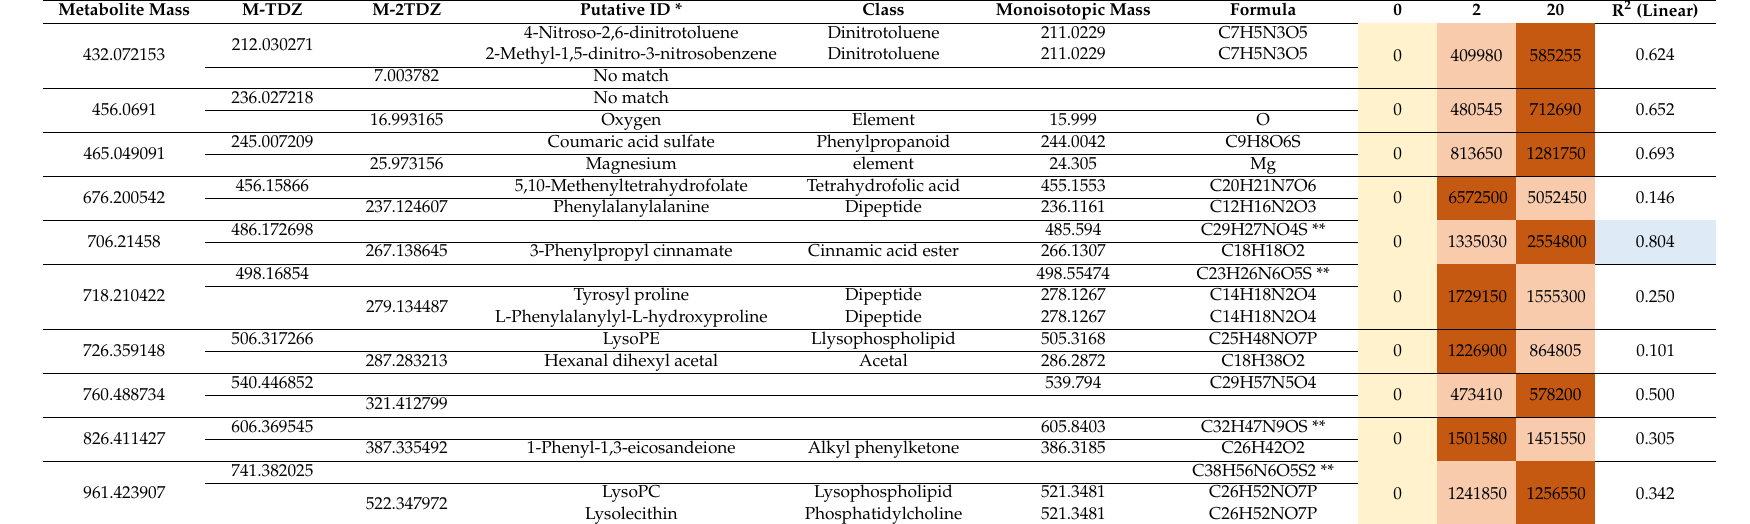
Table 3. Metabolites present in thidiazuron (TDZ) treated tissues and absent in control predicted to have been presented as conjugates of thidiazuron (TDZ). Metabolite mass is the predicted monoisotopic mass of the compound, monoisotopic mass is the known monoisotopic mass (as predicted by ChemSpider). Data is presented as mean ion intensity. M-TDZ is the predicted monoisotopic mass of the compound less the monoisotopic mass of one TDZ molecule (220.041882); M-2TDZ is the predicted monoisotopic mass of the compound less the monoisotopic mass of two TDZ molecules. Regression coe ffi cient (R 2 ) was determined for the linear relationship of 20 µ M > 2 µ M > 0. Shading darkens with increasing